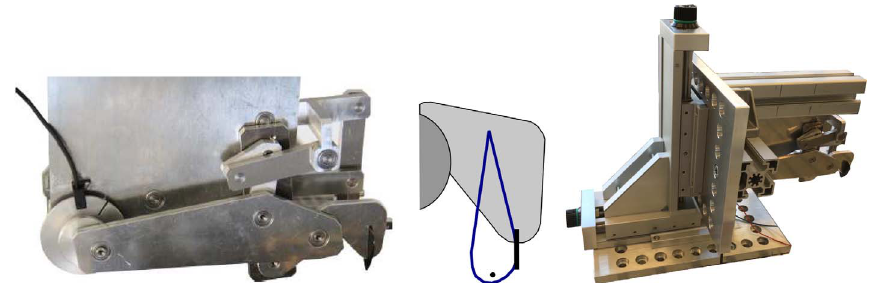
Figure 2. Excitation mechanism (left), schematic path of the plectrum (middle), and application of the mechanism in the experiment (right).